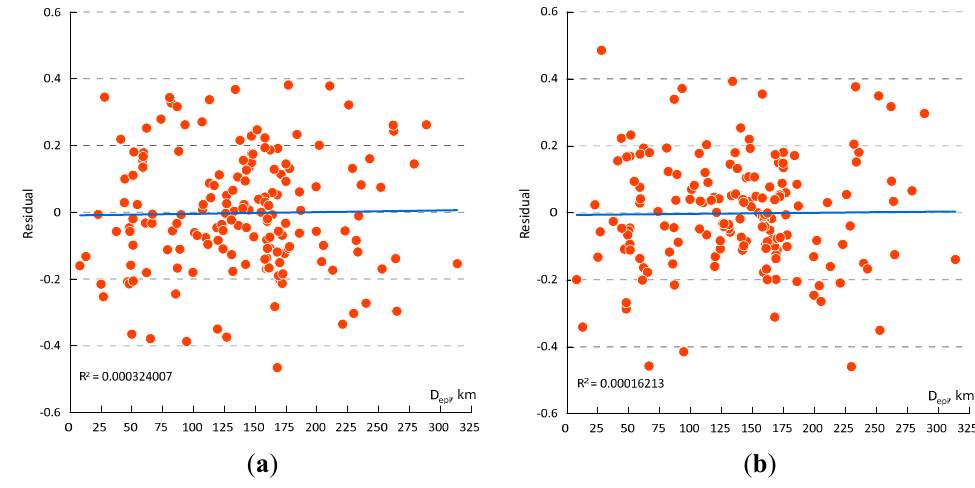
Figure 19. Dependence with distance of intra-event residuals, set 3. ( a ) T = 0.50 s; ( b ) T = 1.00 s.